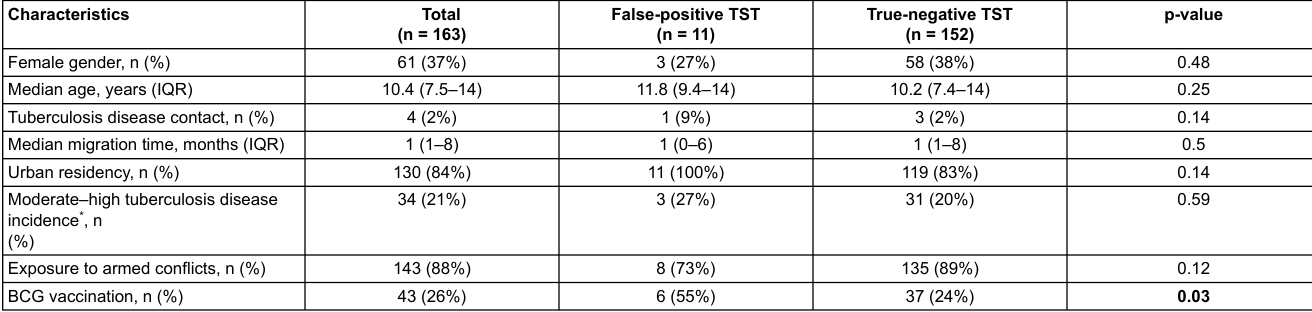
Table 4: Predictors of false-positive tuberculin skin tests results (negative TB-spot tests) in non-tuberculosis children ≥5 years of age (univariate analysis).